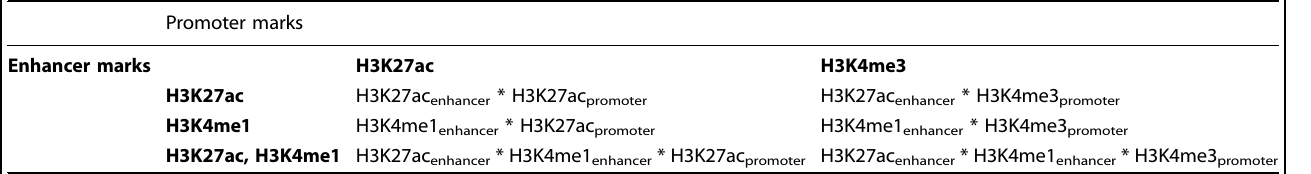
Table 3. Interaction terms between active enhancer and promoter